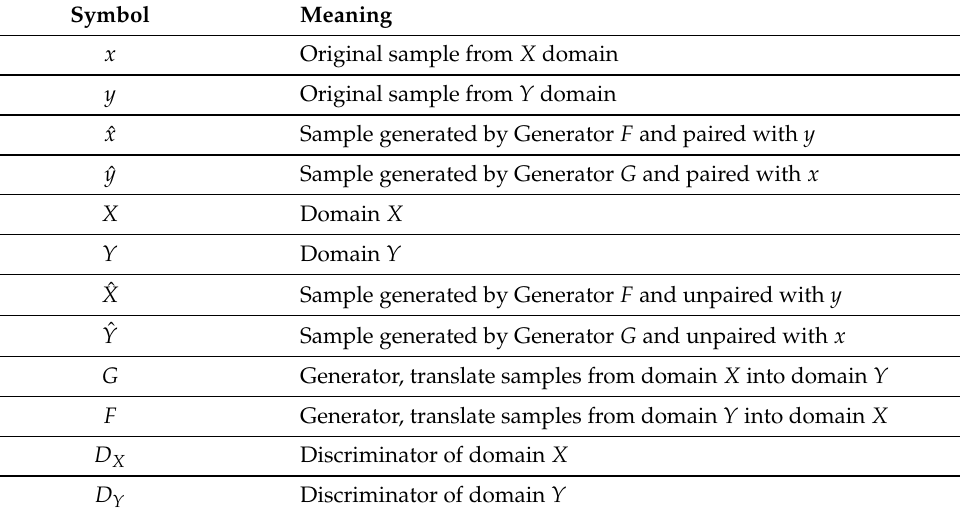
Figure 4. ( a ) The traditional CycleGAN’s schematic diagram [25]. ( b ) The TaijiGNN’s schematic diagram. Table 1. The symbols table of Figure